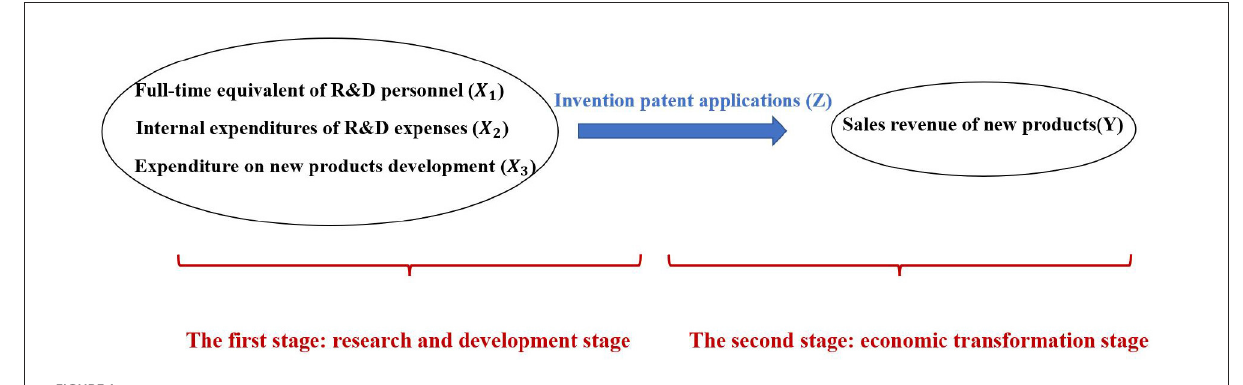
FIGURE1 Innovation network structure of pharmaceutical manufacturing